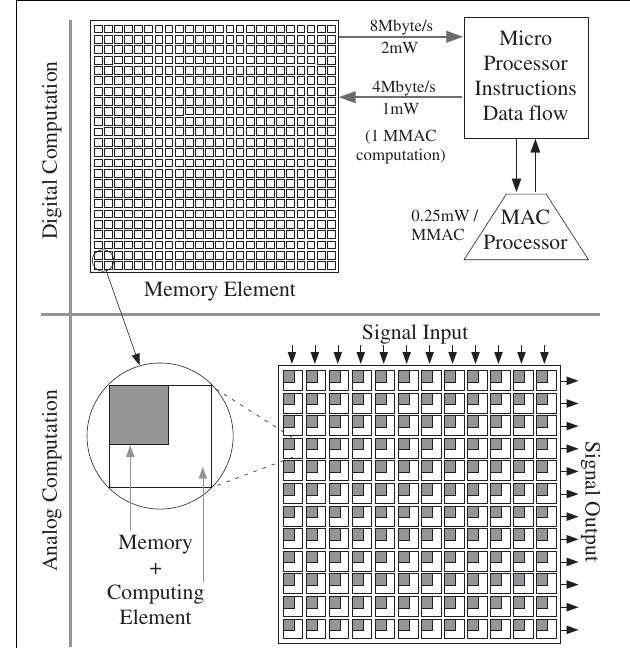
FIGURE 22 | Diagram showing typical computation models for digital and analog approaches. For a typical digital computation, we must access the data (as well as instructions), communicate it to the processor, perform the computation, and communicate the results back to the memory. When this memory is an off-chip device, the resulting power consumed for communication is much higher than an efficient processor. The analog approach directly computes through the memory, and therefore minimizes the resulting issues and complexity due to communication. One could use digital based computation and memory to achieve some advantages, limited by the computational efficiency limits for digital